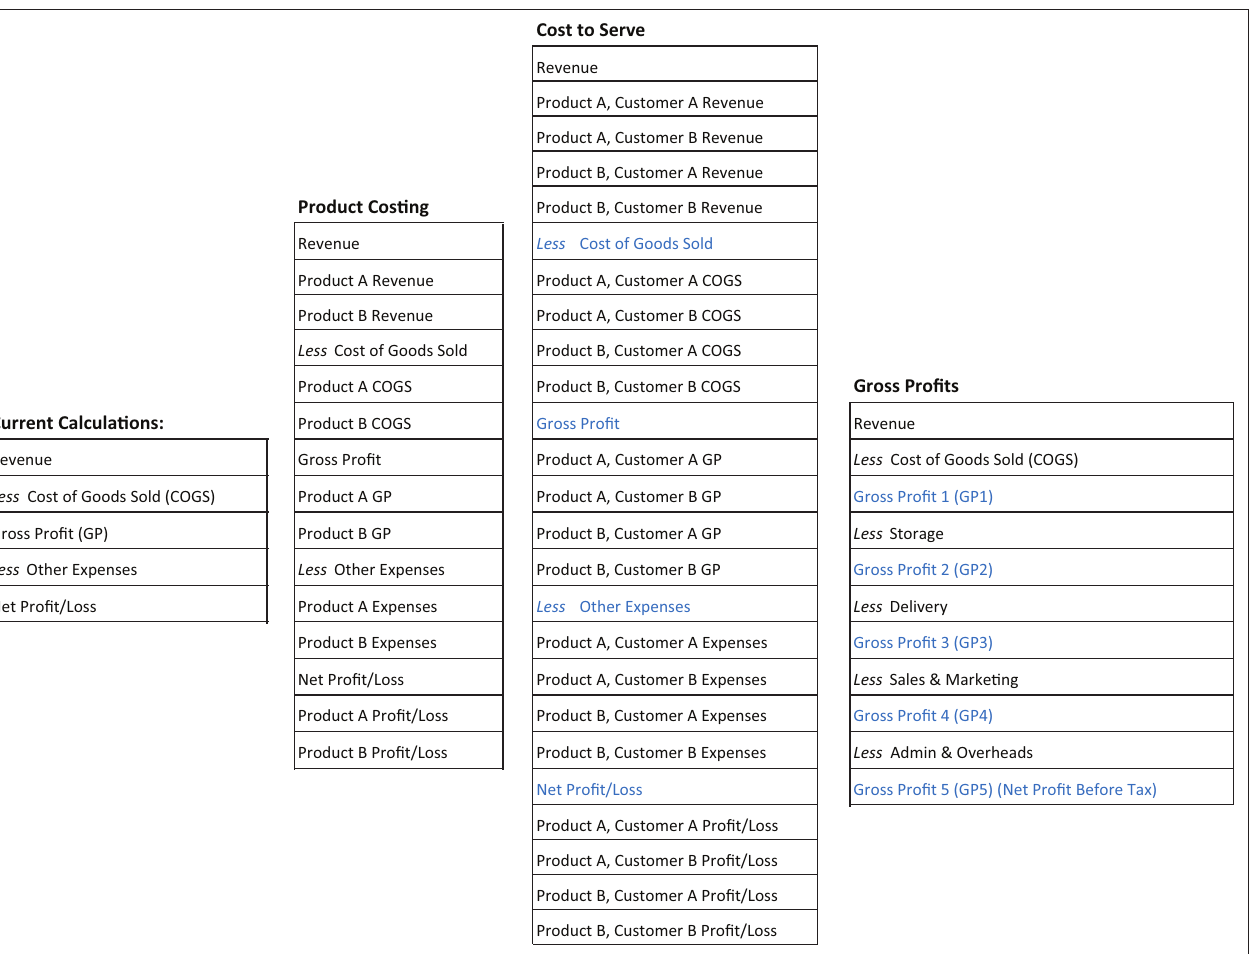
FIGURE 2: The detailed gross profit approach in the developed framework of splitting gross